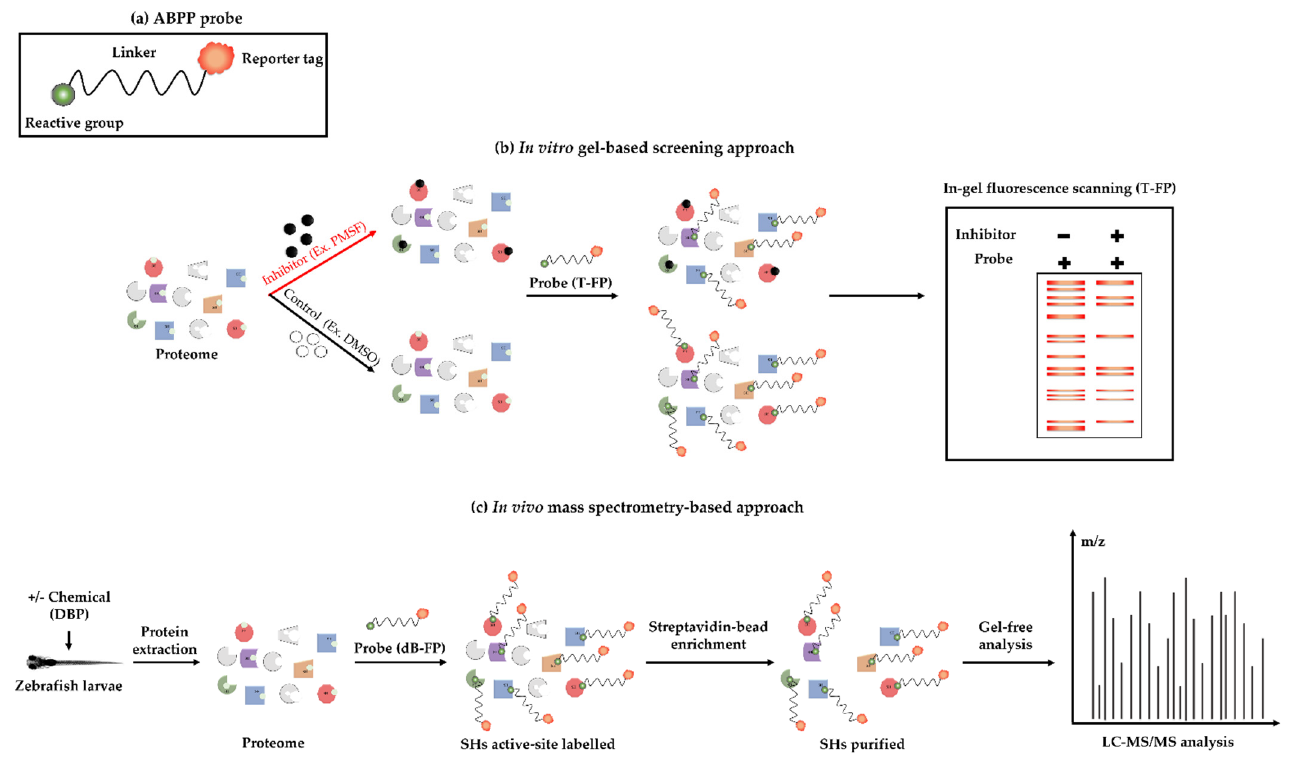
Figure 3. Schematic representation of ABPP approach used. ( a ) Generic structure of an activity-based probe having three components, i.e., the reactive group, a linker, and a reporter tag. ( b ) Protein active-site labelling by competitive ABPP assay (in vitro). For this, zebrafish proteome was pre- incubated with either inhibitor (PMSF) or DMSO, followed by labelling with TAMRA-FP (T-FP). Proteins were separated by SDS-PAGE, followed by in-gel fluorescent scanning to detect the labelled SHs. ( c ) Protein active-site labelling by ABPP assay (in vivo). Zebrafish embryos were exposed to DBP (0, 5 and 100 µ g/L) for 120 h. After exposure, larvae were collected and proteome were extracted, then, SHs were labelled with desthiobiotine-FP (dB-FP) probe followed by streptavidin